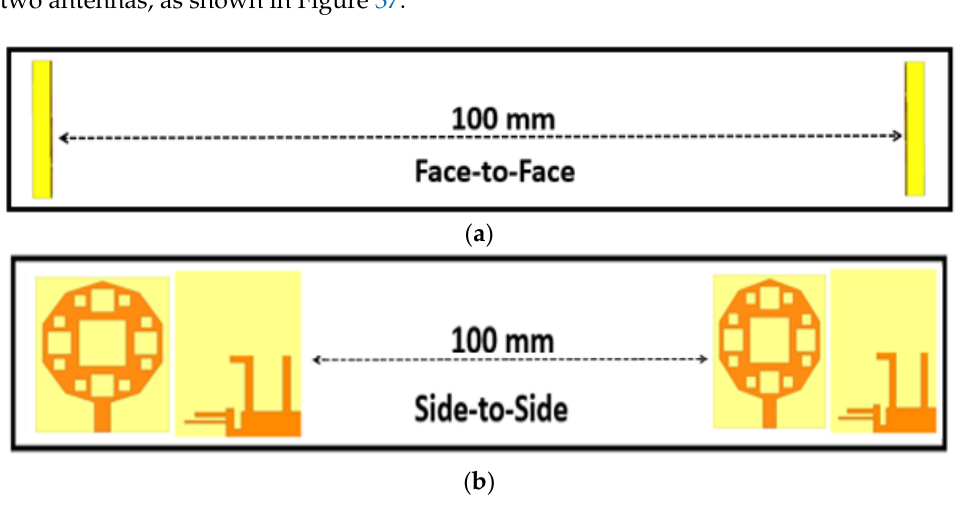
Figure 36. Radiation Pattern at ( a ) 4.35 GHz, ( b ) 5.9 GHz, ( c ) 8.7 GHz, ( d ) 9.7 GHz.